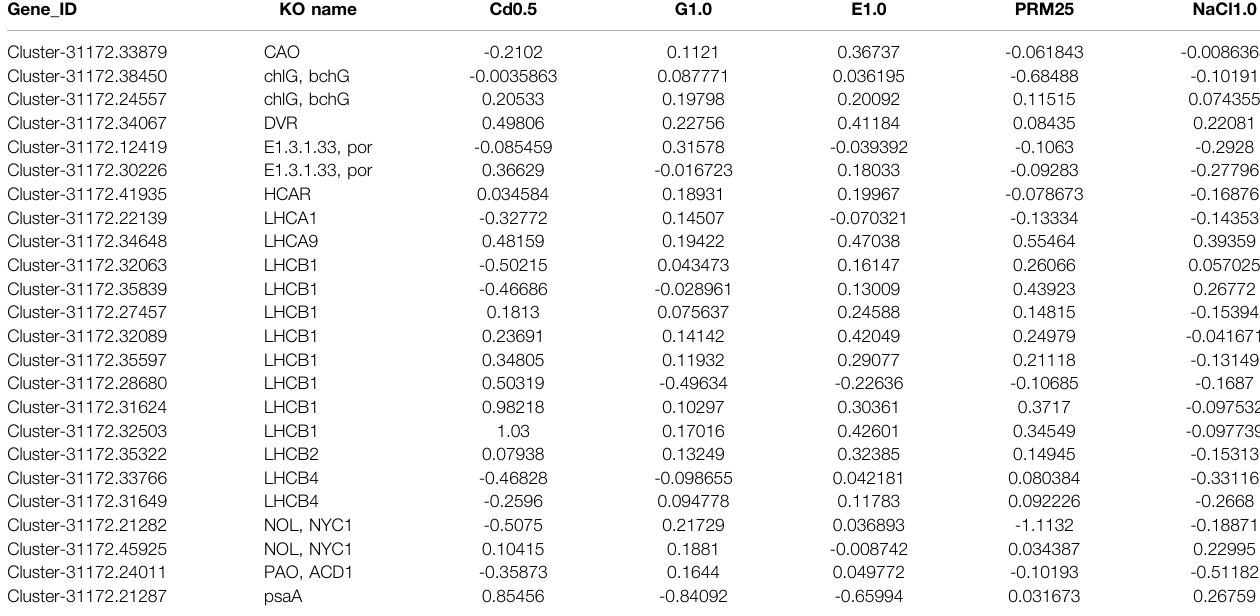
TABLE 3 | The Log2FC (fold change) of selected chlorophyll related genes under different treatments, treatment vs. control. Gene_ID Cluster-31172.XXs were assigned based on our RNA-seq